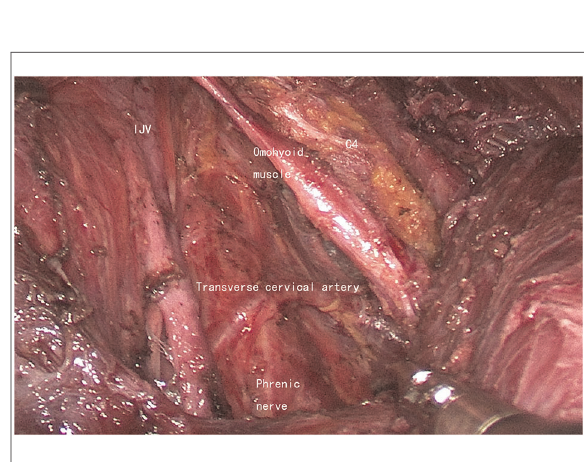
FIGURE 6 The inferior boundary (left side). IJV, internal jugular vein; C4, the fourth branch of the cervical plexus.